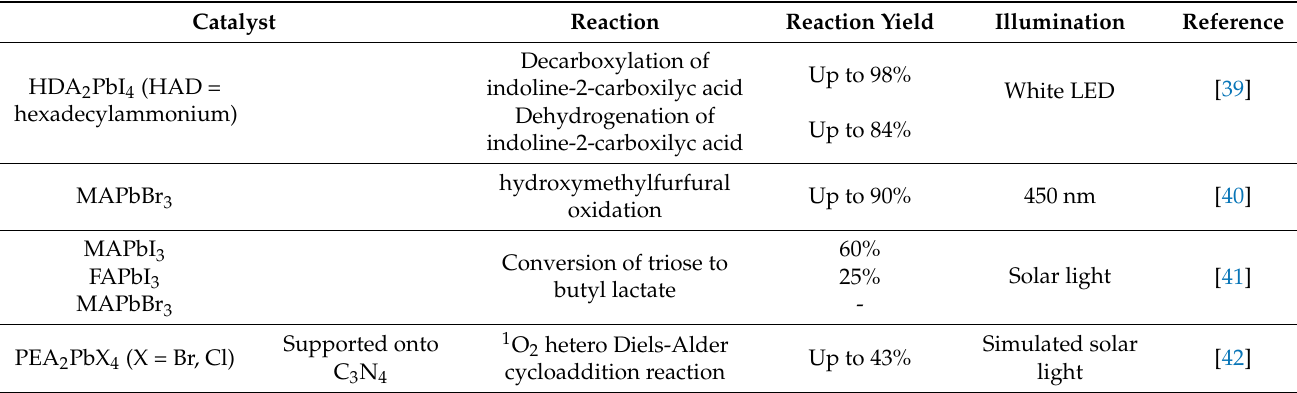
Table 2. Bulk Pb-based photocatalytic systems reviewed in the present paper highlighting the reaction, reaction yield, and illumination